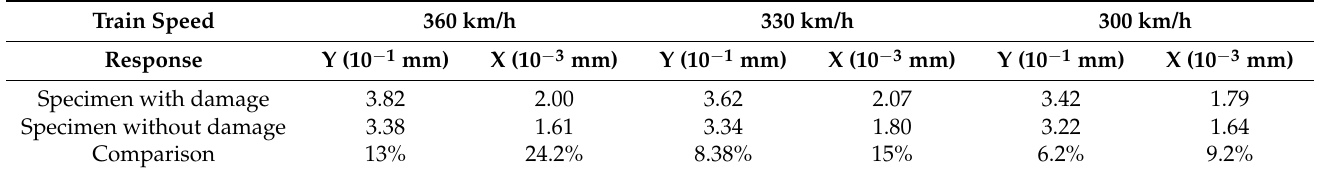
Figure 25. Responses of the composite beam at a train speed of 300 km/h in the case of T-1. Table 7. Comparison of maximum displacement at mid-span of composite